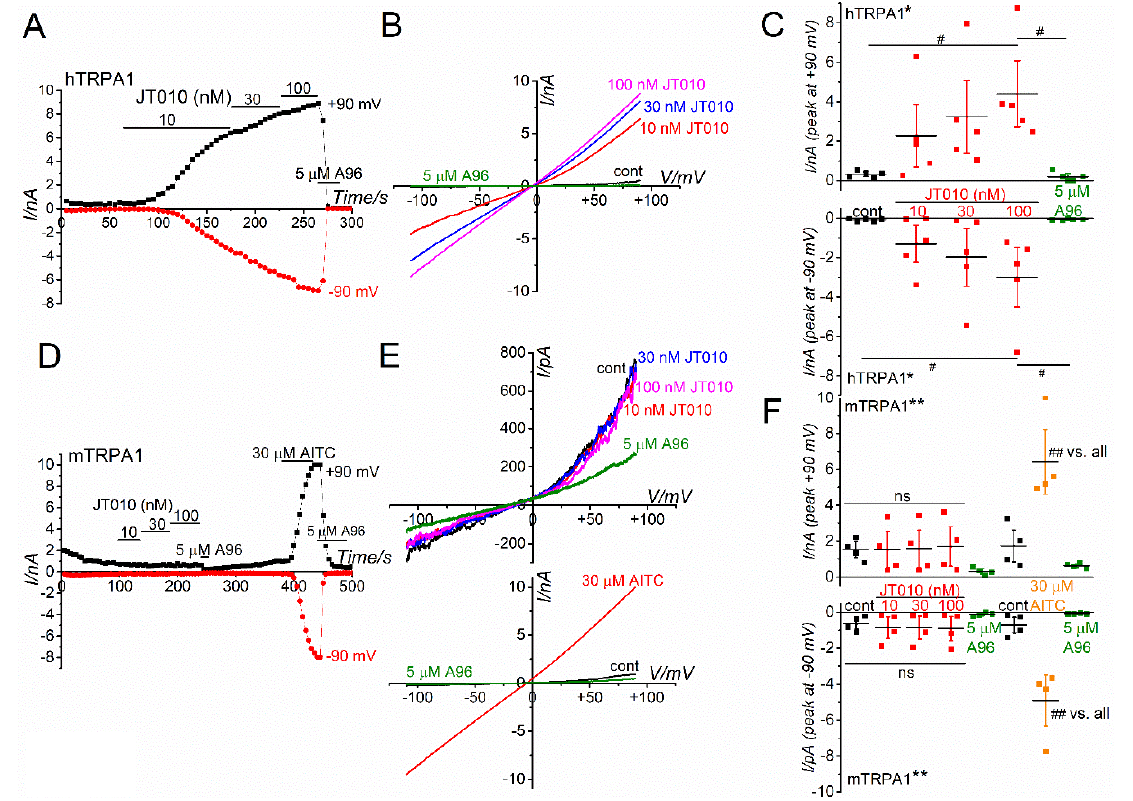
Figure 2. ( A – C ) JT010-induced membrane currents at − 90 and +90 mV in a representative HEK- hTRPA1 cell which was superfused with SBS without Ca 2+ ( A ) and the peak JT010-induced currents are summarized as a concentration-response relationship ( C , five independent experiments). The current and voltage (I–V) relationships under each experimental condition are also shown ( B ). Repeated measures one-way ANOVA: * p = 0.0116. F = 4.28 (+90 mV). Post hoc Tukey–Kramer test: # p = 0.0285 (+90 mV vs. cont), # p = 0.0229 (+90 mV vs. A96). Repeated measures one-way ANOVA: * p = 0.0291. F = 3.37 ( − 90 mV). Post hoc Tukey–Kramer test: # p = 0.0495 ( − 90 mV vs. cont), # p = 0.0468 ( − 90 mV vs. A96). The pipette solution contained 0.3 µ M Ca 2+ to maintain TRPA1 activity. Ramp waveform voltage pulses from − 110 to +90 mV for 300 ms were applied every 5 s at a holding potential of − 10 mV. To confirm the hTRPA1 activity, cells were treated with A96 at 5 µ M at the end of the agonist application. ( D – F ) No effects of JT010 on mTRPA1. The experimental conditions were identical to those demonstrated in ( A ), except HEK-mTRPA1 cell and additional applications of 30 µ M AITC and 5 µ M A96 ( D ). At the end of each experiment, AITC and A96 were applied to confirm the expression of mTRPA1. The peak JT010-and AITC-induced currents are summarized as a concentration-response relationship ( F , four independent experiments). Repeated measures one-way ANOVA: ** p < 0.0001. F = 8.54 (+90 mV). Post hoc Tukey–Kramer test: ## p < 0.0001 (+90 mV, vs. 1st A96 and 2nd A96), ## p = 0.00038 (+90 mV, vs. cont), ## p = 0.00039 (+90 mV, vs. 10